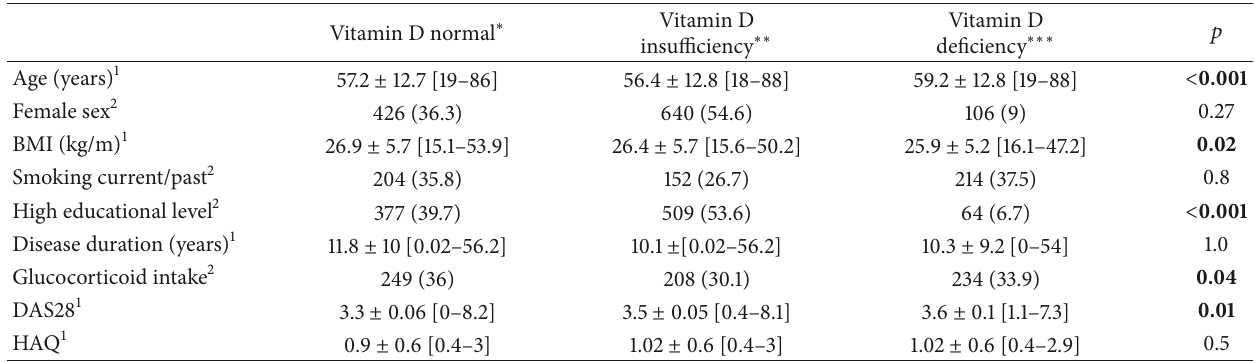
Table 3: Relationship between demographic and disease characteristics of RA patients and vitamin D status.